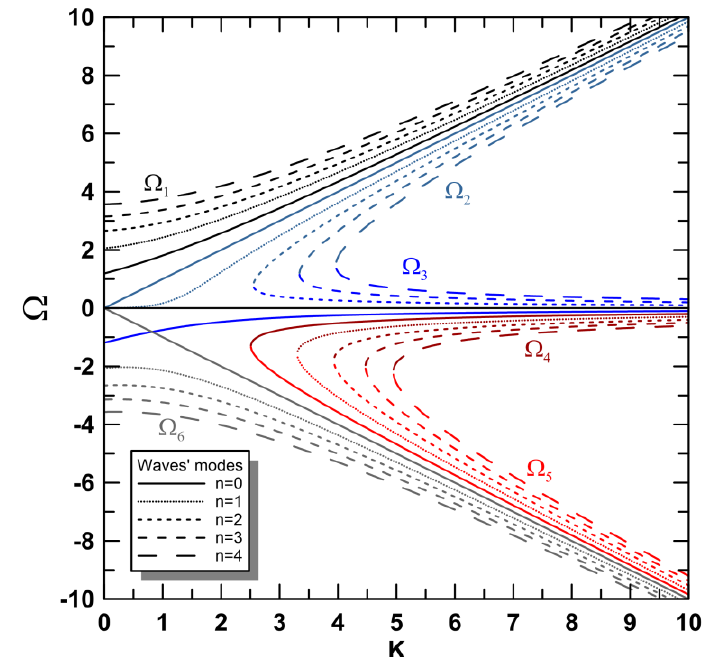
Figure 2. Reduced frequencies (Ω) as a function of the reduced wavenumber (K) and wave modes n displayed in linear scale. The six roots from the sextic equation (from Ω 1 to Ω 6 ) are shown when these are real, and omitted, when it is complex, or when Ω = 0 (for instance, Ω 3 = 0 for mode n = 1). The six roots are shown with different colors, and wave modes are exhibited with distinct line styles. The roots Ω 1 , Ω 2, and Ω 3 correspond to waves propagating downstream (except for mode n = 0 of Ω 3 ), while Ω 4 , Ω 5, and Ω 6 represent waves that propagate upstream relative to the mean zonal flow.